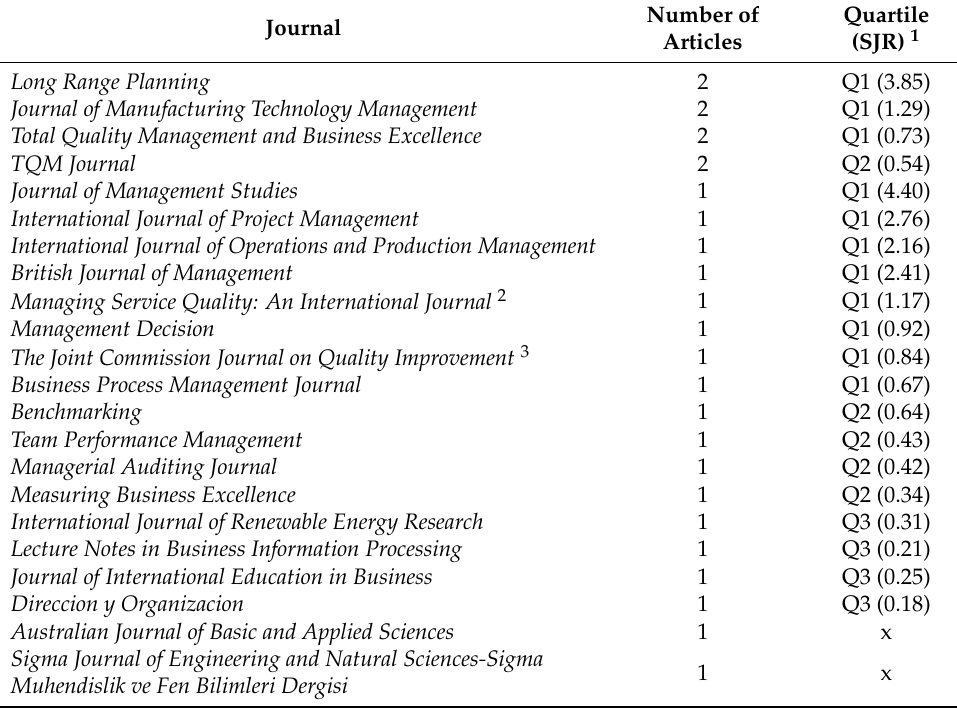
Table 3. Journals.